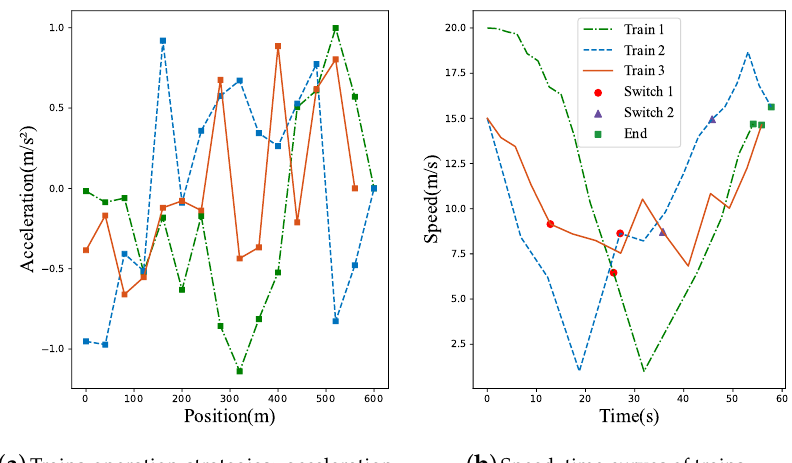
( b ) Speed–time curves of trains. Figure 6. Improved PSO strategies and operation curves in scenario 1.